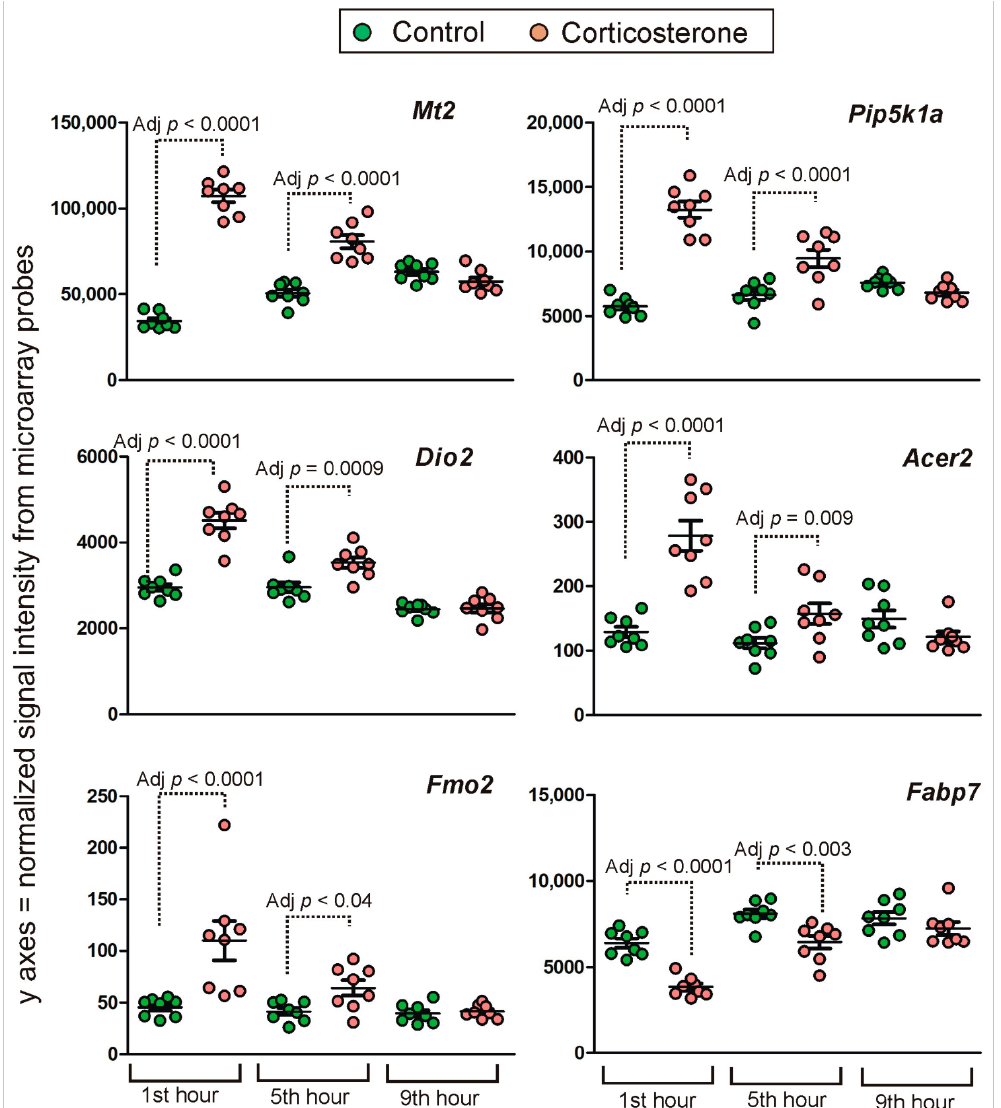
Figure 11. Examples of genes displaying intermediate primary effects. Y axis indicates probe signal intensity decomposed into green and red channel after final background correction, within-array and between-array normalization. All data are available in File